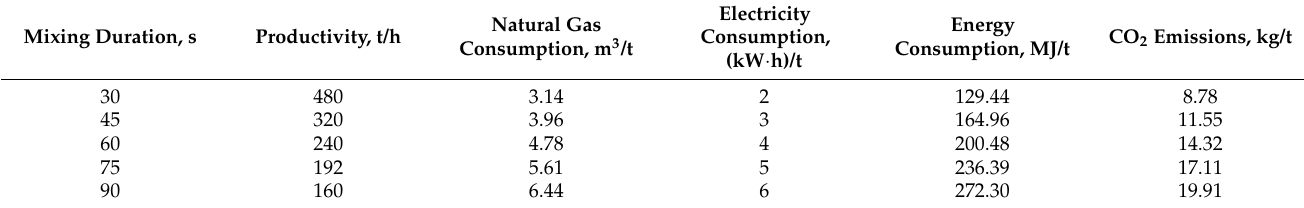
Table 6. Energy consumption and CO 2 emissions for RHMA produced in a plant with different mixing durations.